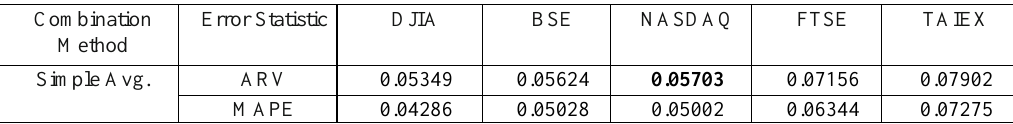
Table 4 . Performance of combined methods on five